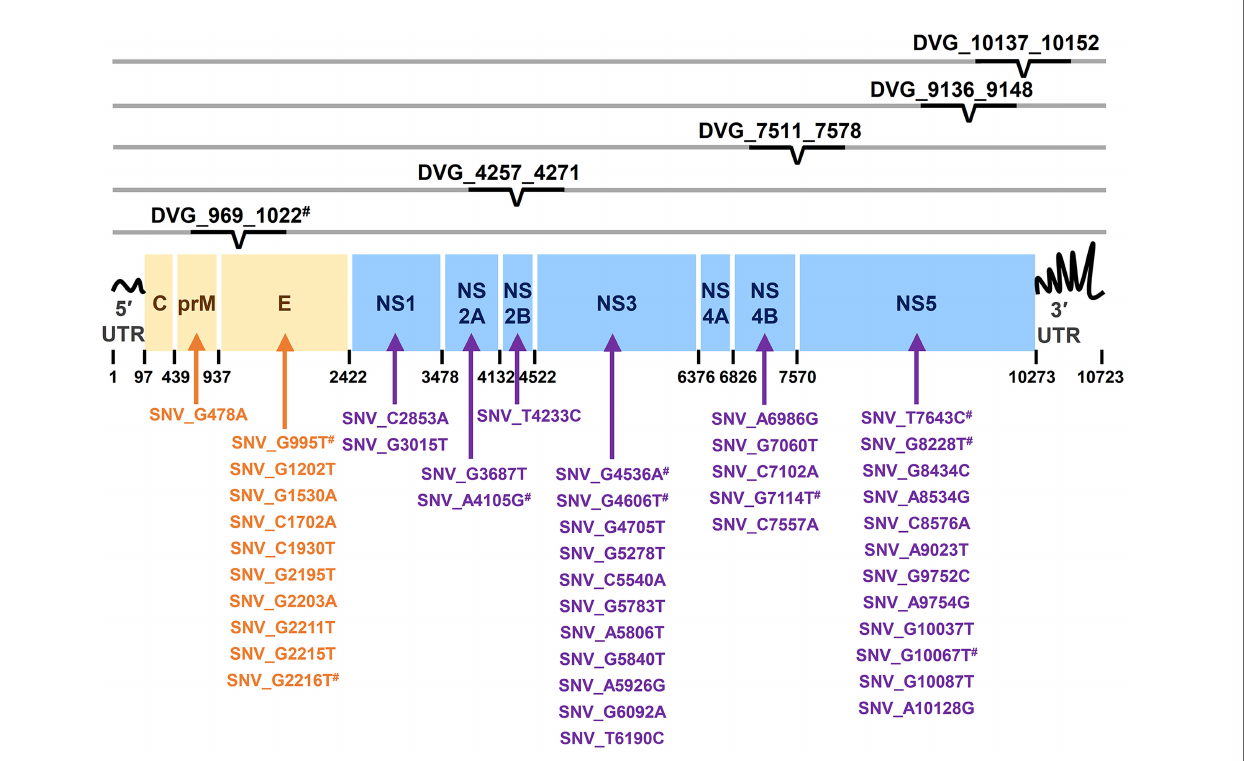
( Table 3 ) and higher AUROC values (0.966 ± 0.064 vs. 0.946 ± 0.067) ( Table 3 and Figure 6 ) than the model within p < 0.001